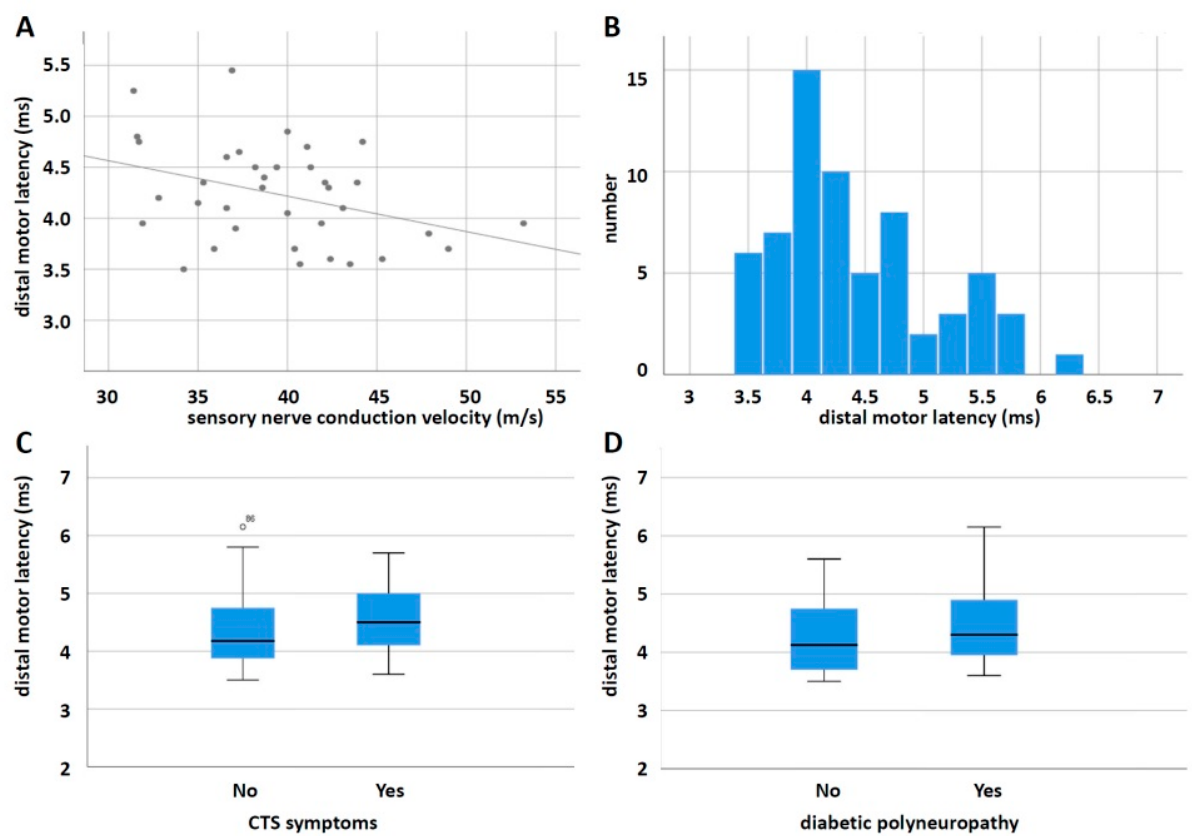
Figure 2. Nerve conduction studies of the median nerve. ( A ) Scatter plot of sensory nerve conduction velocity and distal motor latency. ( B ) Histogram of distal motor latencies. ( C ) Box plots of distal motor latencies in patients with and without CTS symptoms. ( D ) Box plots of distal motor latencies in patients with and without diabetic polyneuropathy.